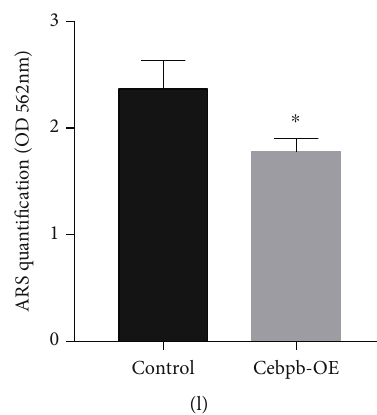
Figure 3: Cebpb knockdown promoted mSSC osteogenic di ff erentiation. (a) Expression of osteogenic di ff erentiation markers determined by western blot in the Cebpb inhibition group and the control group. (b) Quanti fi cation of result (a). (c) Expression of osteogenic di ff erentiation markers determined by qPCR in the Cebpb inhibition group and the control group. (d) Alizarin red S staining and alkaline phosphatase staining of mSSCs in the Cebpb inhibition group and the control group. Scale bar: 200 μ m. (e) Quanti fi cation of alkaline phosphatase staining of result (d). (f) Quanti fi cation of alizarin red S staining of result (d). (g) Expression of osteogenic di ff erentiation markers determined by western blot in the Cebpb overexpression group and the control group. (h) Quanti fi cation of result (g). (i) Expression of osteogenic di ff erentiation markers determined by qPCR in the Cebpb overexpression group and the control group. (j) Alizarin red S staining and alkaline phosphatase staining of mSSCs in the Cebpb overexpression group and the control group. Scale bar: 200 μ m. (k) Quanti fi cation of alkaline phosphatase staining of result (j). (l) Quanti fi cation of alizarin red S staining of result (j). Cebpb-sh1: mSSCs stably expressing the Cebpb-shRNA1 sequence; Cebpb-sh2: mSSCs stably expressing the Cebpb-shRNA2 sequence; Cebpb-OE: mSSCs stably expressing the Cebpb full-length cDNA sequence. ∗ p < 0 : 05 , ∗∗ p < 0 : 01 , and ∗∗∗ p < 0 : 001